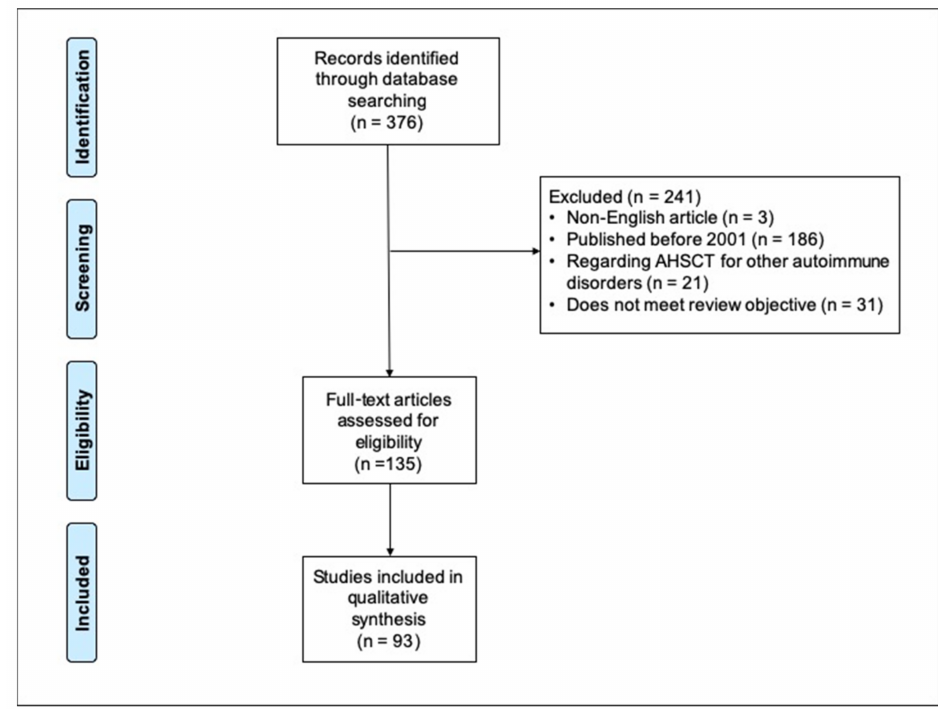
Figure 1. PRISMA flow. AHSCT, autologous hematopoietic stem cell